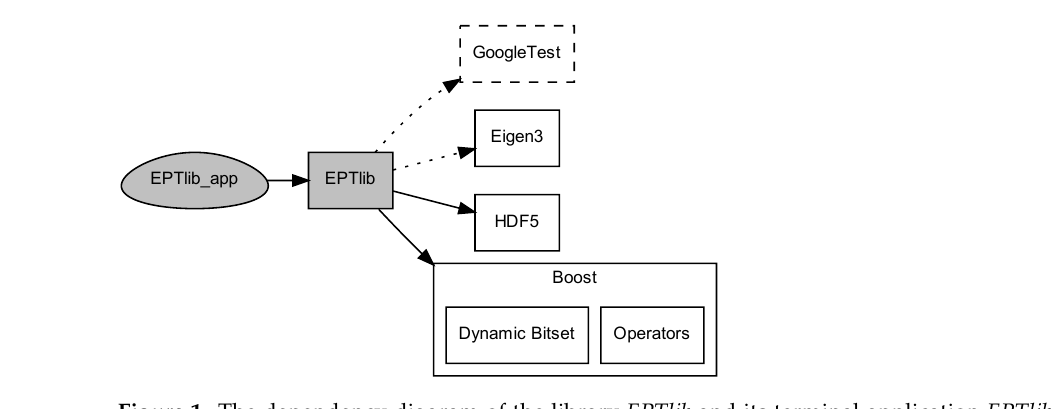
Figure 1. The dependency diagram of the library EPTlib and its terminal application EPTlib_app . The dotted arrow denotes a private dependence, whilst the solid arrow denotes a public one. The dashed box denotes an optional library.